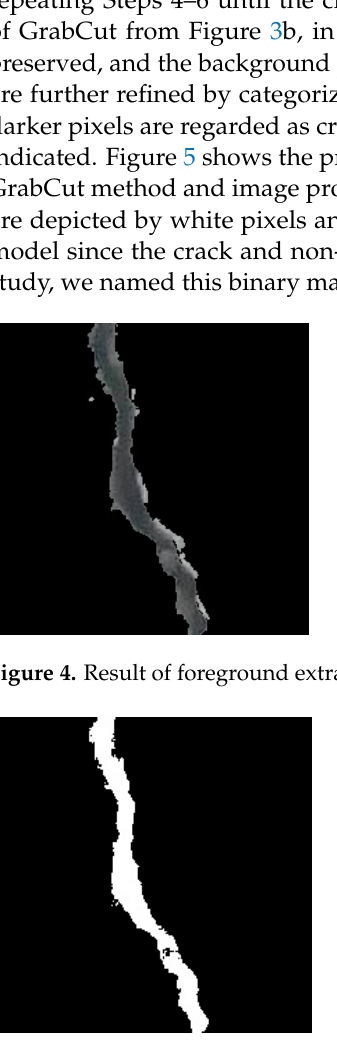
Figure 5. Preliminary result of crack segmentation by preserving darker pixels in the foreground from Figure 4. Crack pixels are denoted by white color in this